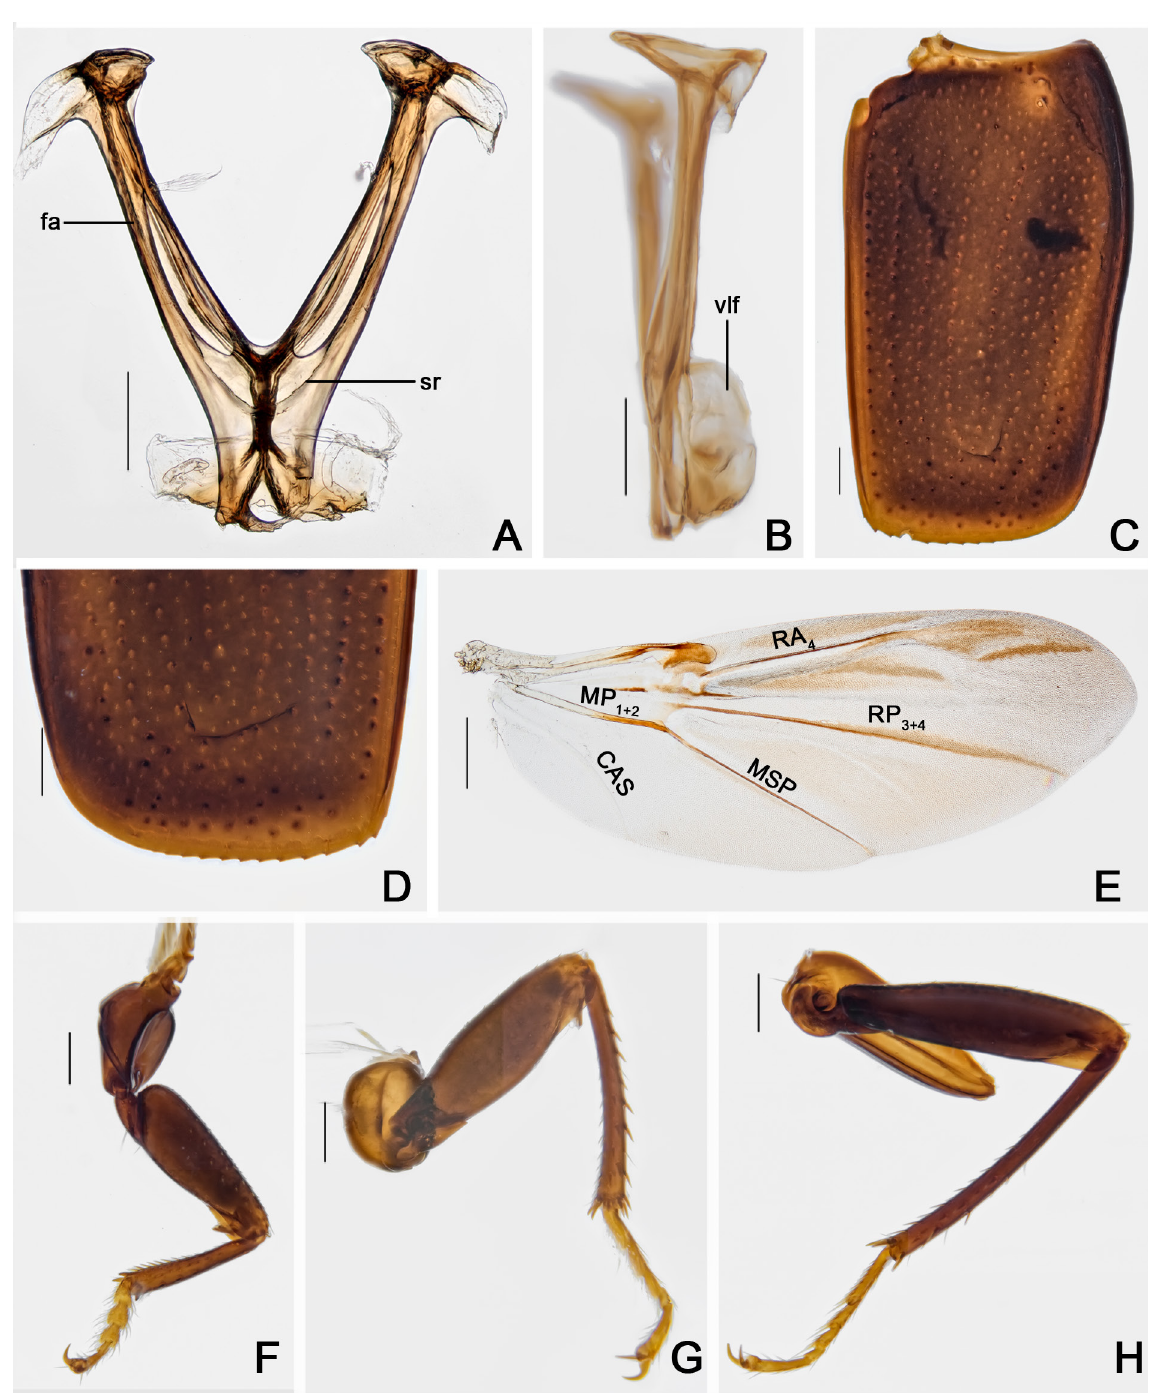
Fig. 10. Cyparium achardi sp. nov., paratype, ♂ (CELC). A–B . Metendosternite. A . Dorsal view. B . Lateral view. C–D . Elytron. C . Entire. D . Apex. E . Hind wing. F–H . Legs. F . Fore. G . Middle. H . Hind. Specimen collected at Mata do Paraíso, Viçosa (MG, Brazil). Abbreviations: CAS = cubitoanal strut; fa = furcal arms; MP = medial field; MSP = medial spur; RA = radius anterior; RP = radius 1+2 4 3+4 posterior; sr = ‘stalk ridge’; vlf = ventral longitudinal flange. Scale bars: A–D, F–H = 0.2 mm; E = 0.5